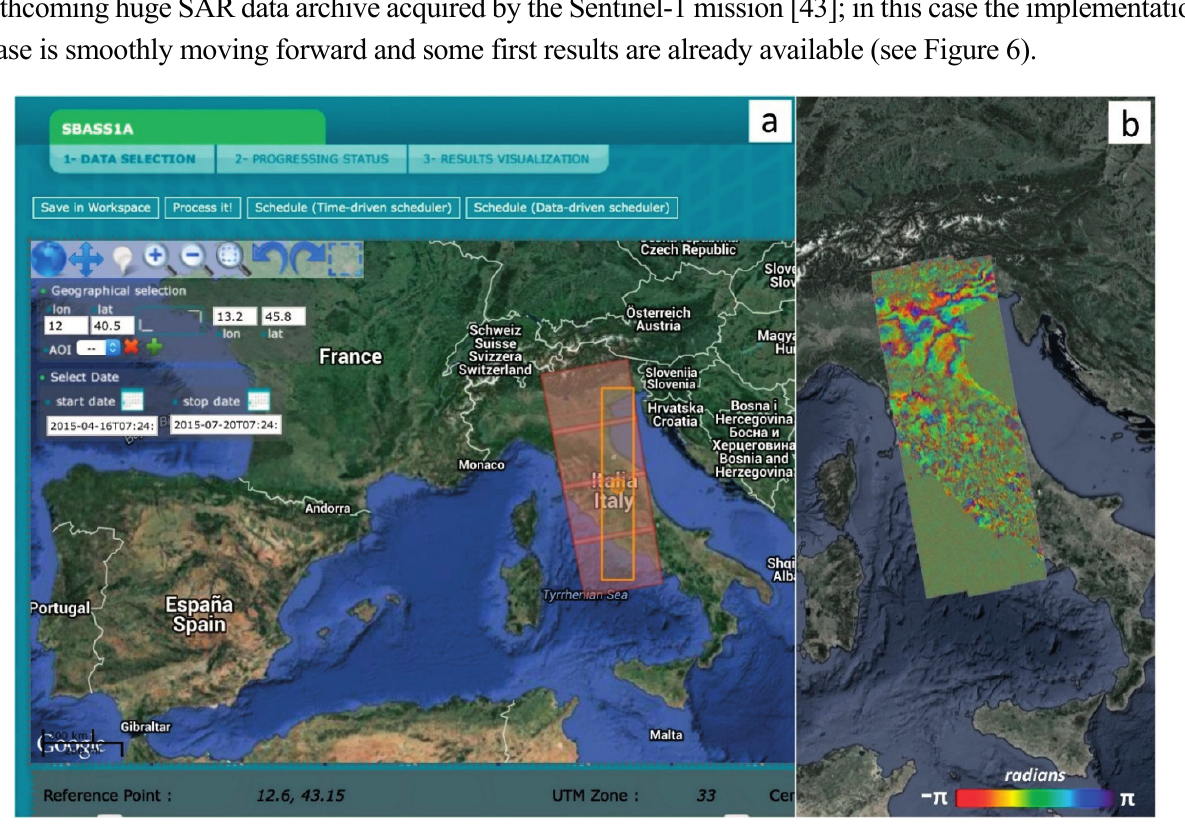
Figure 6. Sentinel-1 first results. ( a ) G-POD web interface relevant to the P-SBAS tool for DInSAR analysis of Sentinel-1 data, and ( b ) example of an interferogram generated through the P-SBAS tool in an unsupervised way, by exploiting a Sentinel-1 interferometric pair obtained merging four slices per each acquisition. Contains Copernicus data